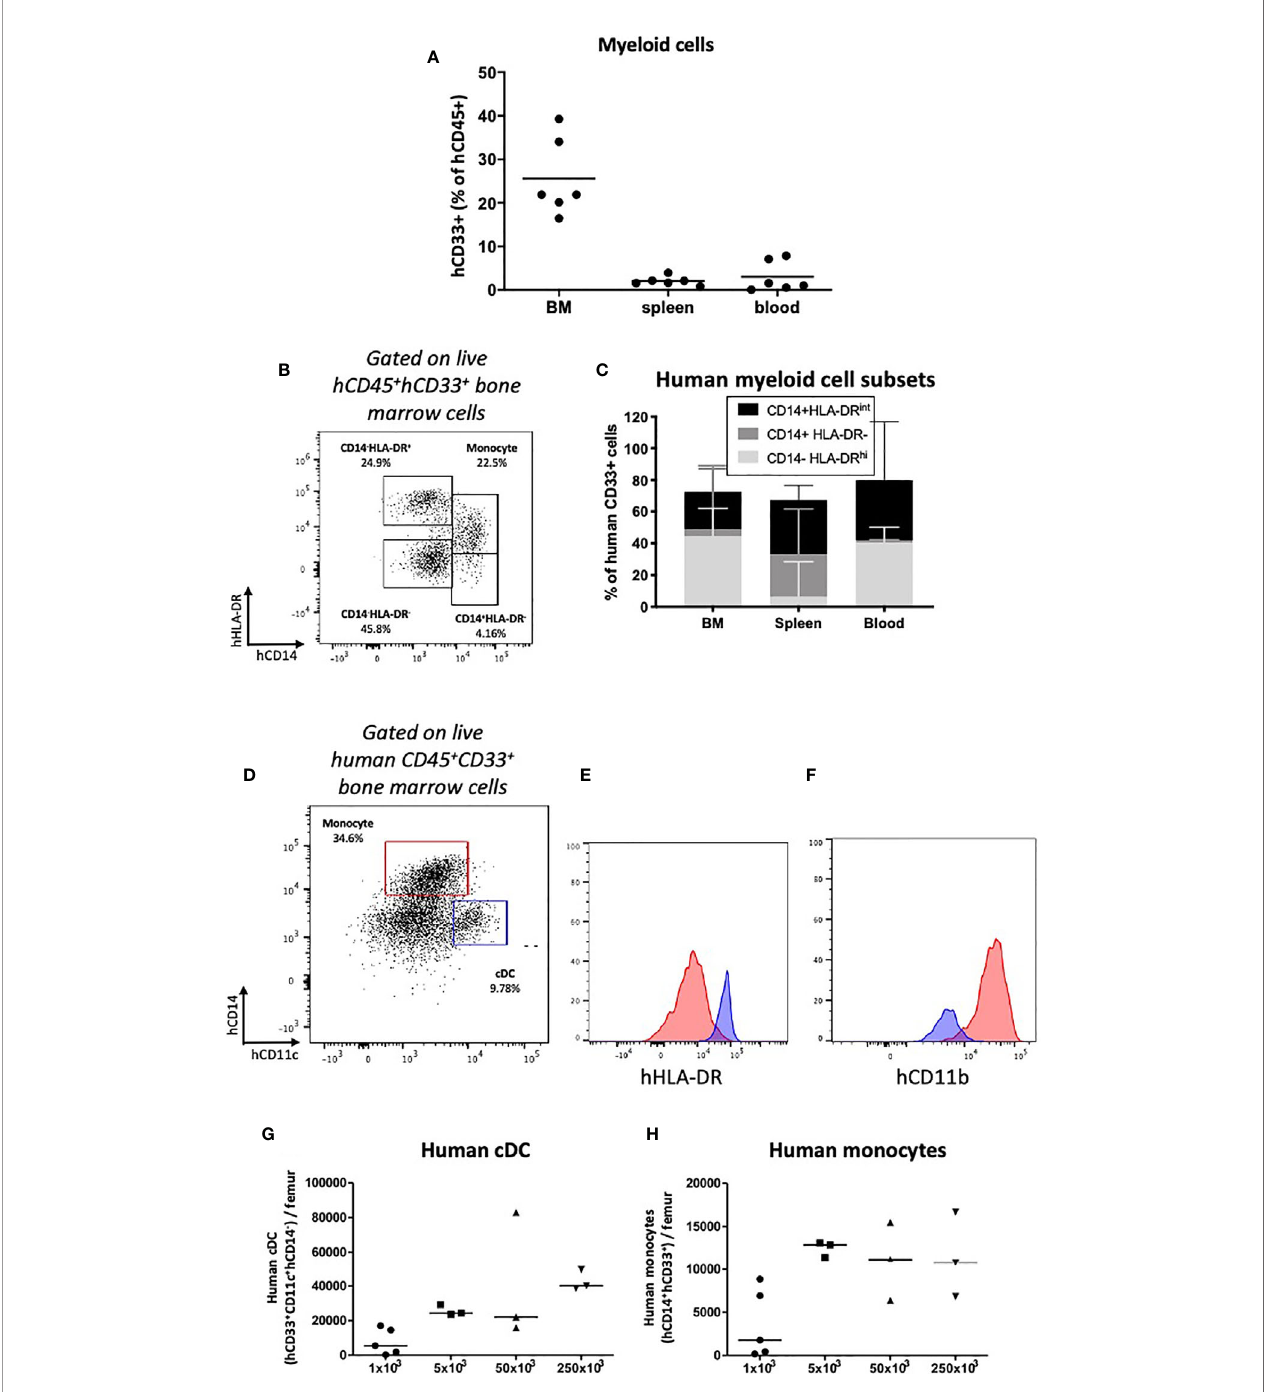
FIGURE 6 | Human myeloid cell engraftment in HSPC-NBSGW mice. (A) Frequencies of human CD33 + myeloid cells in the bone marrow, spleen and peripheral blood of HSPC-NBSGW mice 20-22 weeks after cell injection. (B) Representative fl ow cytometric plot and (C) corresponding frequencies of myeloid subsets based on CD14 and HLA-DR expression. (D) Representative fl ow cytometry plot and (E, F) corresponding histograms demonstrating human conventional dendritic cells (cDCs) (blue; hCD11c + hCD14 - hCD33 + ) and human monocytes/macrophages (red; hCD14 + hCD33 + ) in the bone marrow of HSPC-NBSGW mice (50x10 3 dose shown). Histograms demonstrate high HLA-DR expression and low CD11b expression in cDCs (blue histograms) as compared with monocytes (red histograms). (G) Numbers of human cDCs (hCD11c+hCD14-hCD33+) (H) and human monocytes/macrophages (hCD14 + hCD33 + ) in the bone marrow of one femur in mice receiving different numbers of hUCB CD133 + HSPCs. Bars indicate median values (A, G, H) and median + IQR (C)